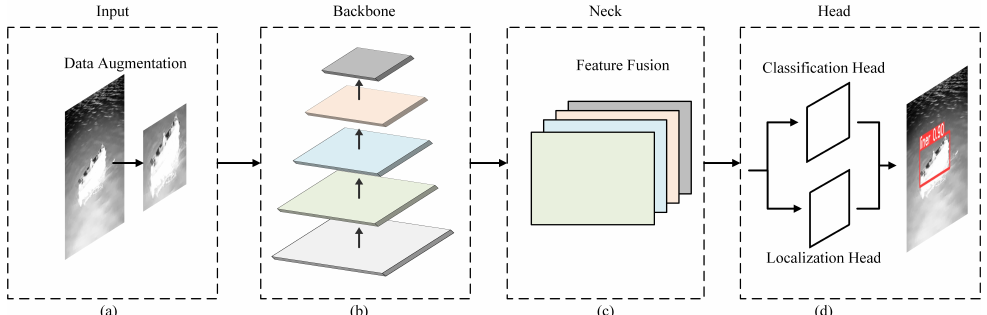
Figure 1. Modern detection structures with the input, backbone, neck and head. ( a ) Input: data preprocessing modules, such as data augmentation; ( b ) Backbone: feature extraction module; ( c ) Neck: multiscale feature fusion module; ( d ) Head: object classification and localization